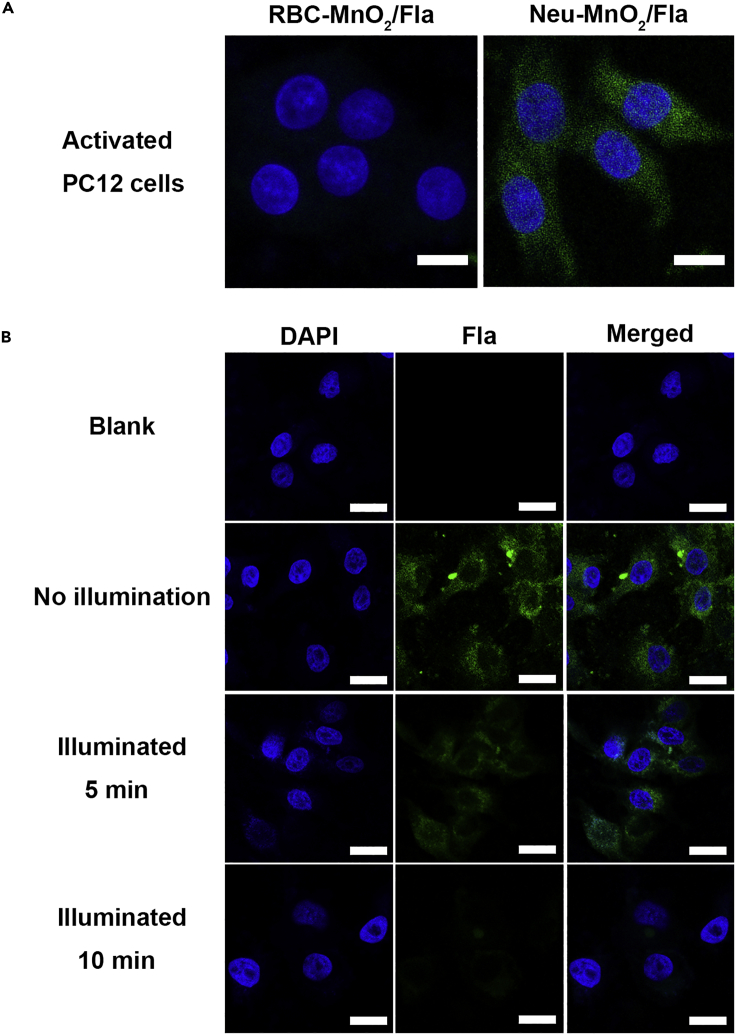
The Inflammation Targeting Ability and Intracellular CO Delivery of Neu-MnO2/Fla(A) Fluorescent images of PC12 cells after incubation with RBC-MnO2/Fla (25 μg/mL) and Neu-MnO2/Fla (25 μg/mL), respectively. Cells were activated with LPS before being treated with nanoparticles. Scale bars: 10 μM.(B) Fluorescent images of PC12 cells exposed to Neu-MnO2/Fla (25 μg/mL) with subsequent illumination. Blue and green represented DAPI and Fla fluorescence, respectively. Scale bars: 25 μM.